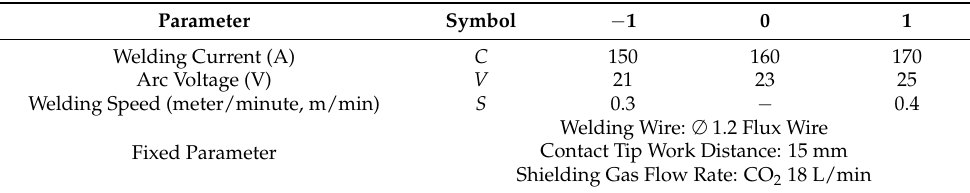
Table 3. Flux cored arc welding parameters and their levels [7].